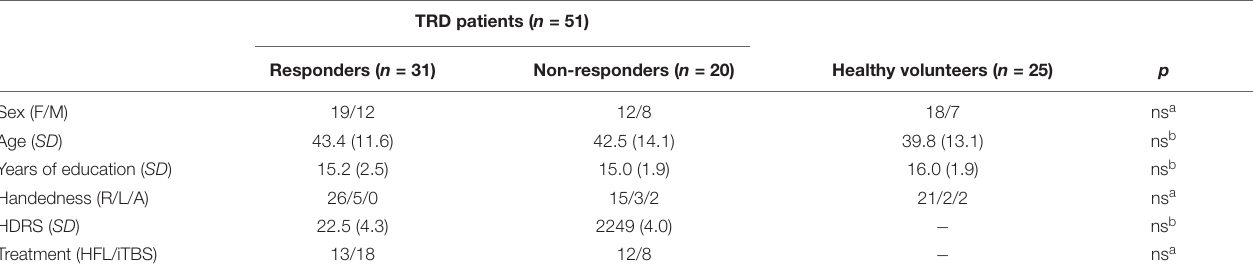
TABLE 1 | Demographics and clinical characteristics of HC and TRD patients by responder and non-responder